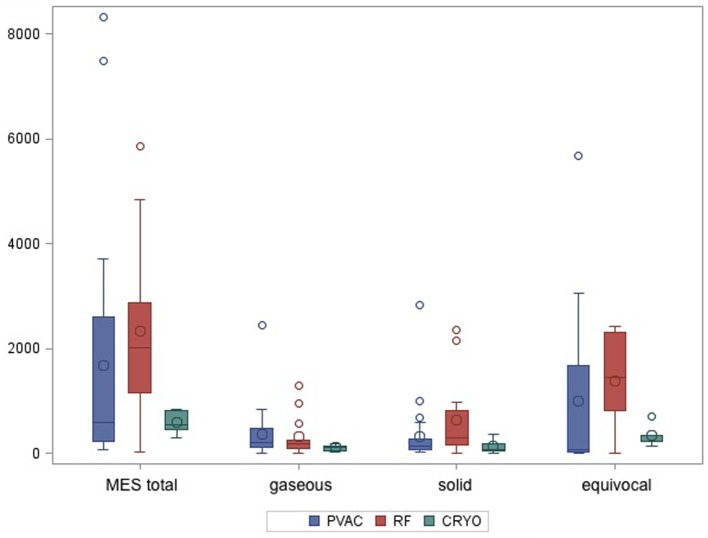
Boxplot shows median values of total microembolic signal (MES) burden and subdivision of MES according to the different ablation techniques.